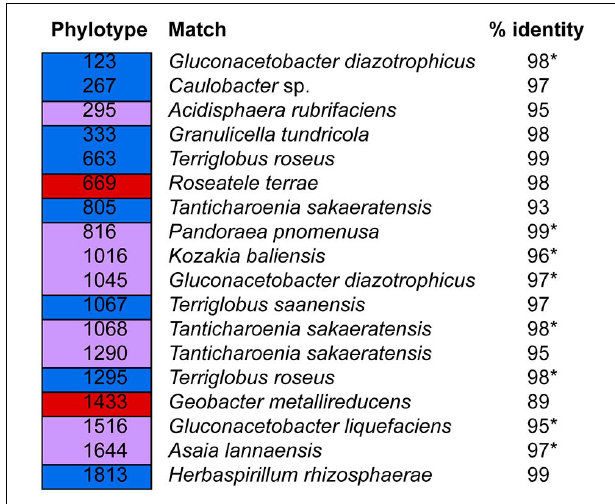
FIGURE 5 | Shared and host species-specific phylotypes. Blue: phylotypes found in all P. engelmannii samples but not in any of the P. flexilis samples. Red: phylotypes found in all P. flexilis samples but not in any of the P. engelmannii samples. Purple: indicates phylotypes recovered from all samples (i.e. , both species). An asterisk indicates that the phylotype is included in Figure 2 .